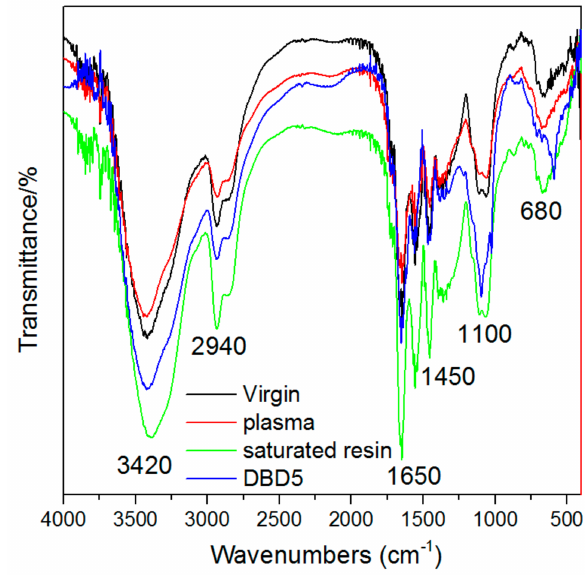
Figure 6. FT-IR spectra of the four kinds of virgin, plasma, saturated and DBD5 resins.